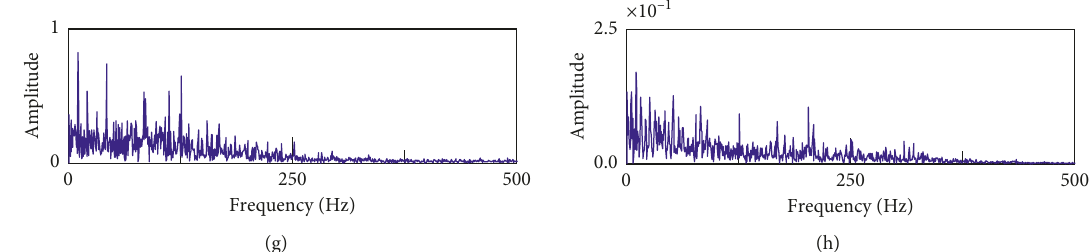
Figure 27: Results obtained by EEMD: (a–d) IMFs; (e–h) squared envelope spectra (red dashed lines: f (c)(a)fb-kurt.2 Figure 28: Results obtained by the fast kurtogram: (a) kurtogram; (b) squared envelope of the node with the largest kurtosis value; (c) squared envelope spectrum of (b) (red dash-dotted lines: f BSF and its